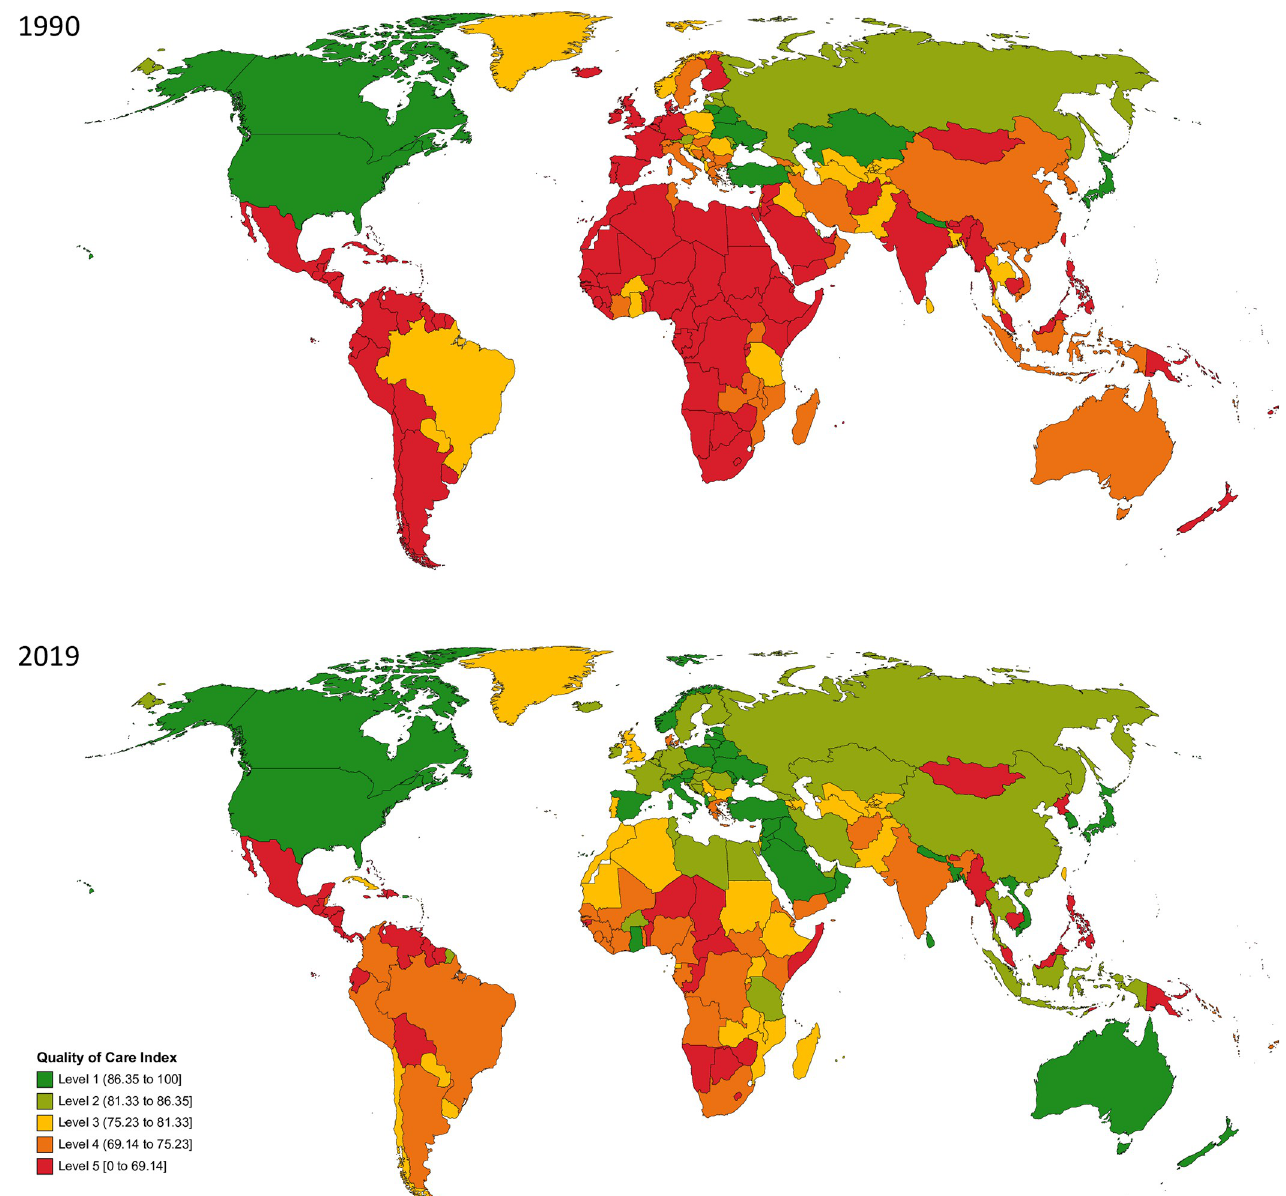
Fig 1. Quality of care index for peptic ulcer disease by country in 1990 and 2019.